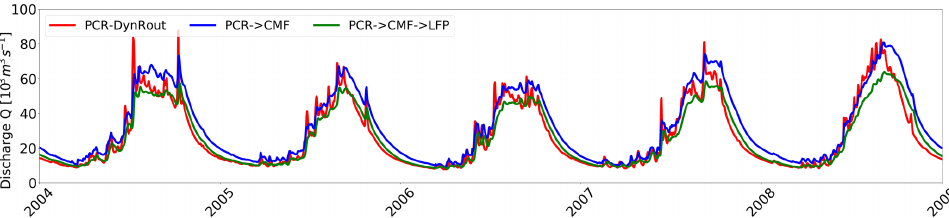
Figure 6. Simulated discharge at a river monitoring station from coupled hydrologic and hydrodynamic models (reproduced from Fig. 6 in Hoch et al., 2019). Table 3. Models available as components in the Python Modeling Tool pymt